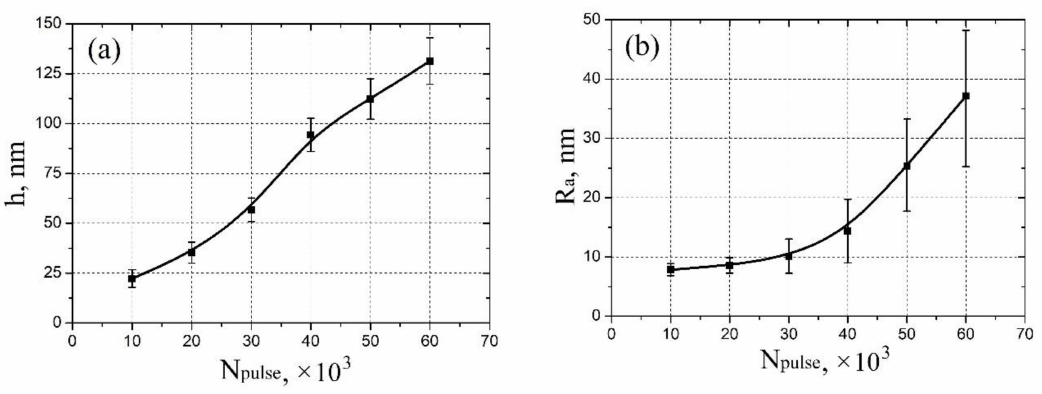
Figure 2. Experimental study of vanadium oxide film geometrical parameters dependence on pulse number: ( a )—thickness; ( b )—surface roughness.